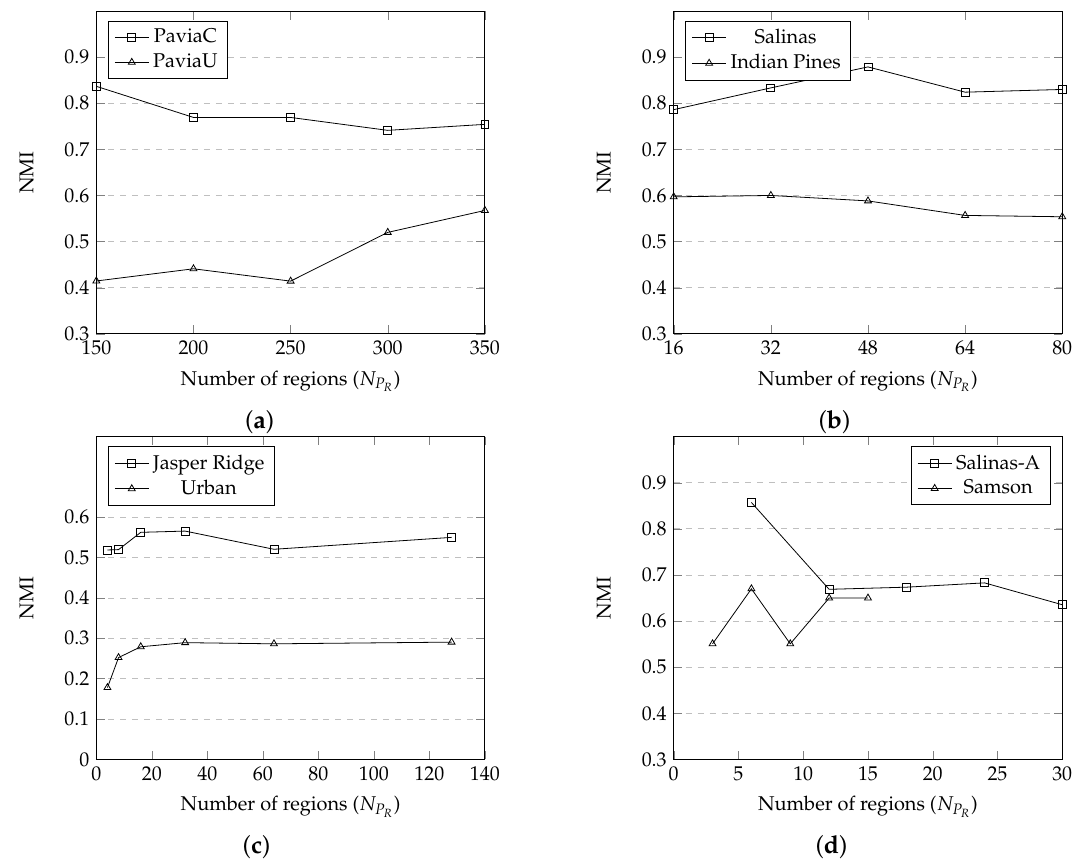
Figure 5. Average Normalized Mutual Information (NMI) values (10 runs) versus the number of regions ( P R ) for ( a ) PaviaC and PaviaU, ( b ) Salinas and Indian Pines, ( c ) Jasper Ridge and Urban, and ( d ) Salinas-A and